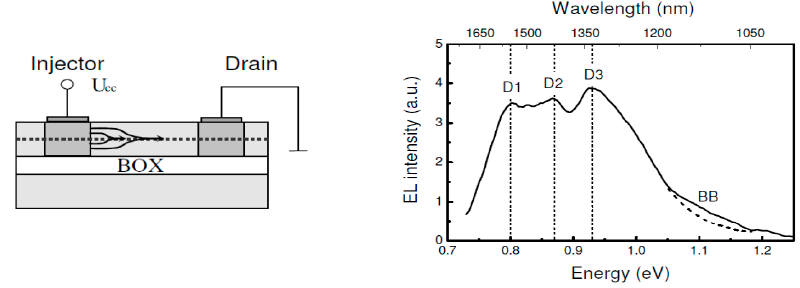
Figure 25. Scheme of the two-electrode all silicon LED integrated in a SOI layer containing a dislocation network. As electrodes two p–n junctions are used. They are located at a distance of 2 μ m within the 80 nm thick SOI layer. The EL spectrum was observed at 300 K for a forward current of 60 mA. The emission is strong and can already be detected at current of few mA by a simple panchromatic camera-based system.